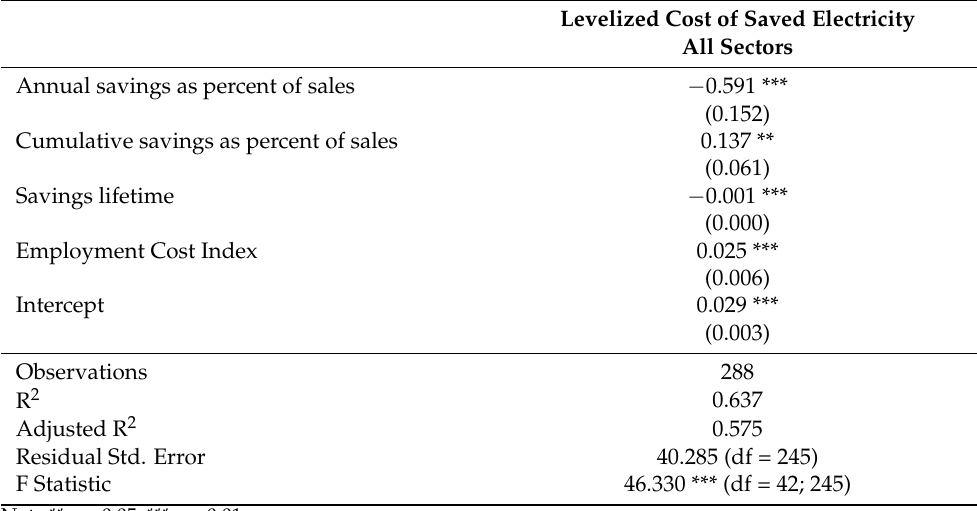
Table 4. Program administrator and program year fixed-effects model with weighted least